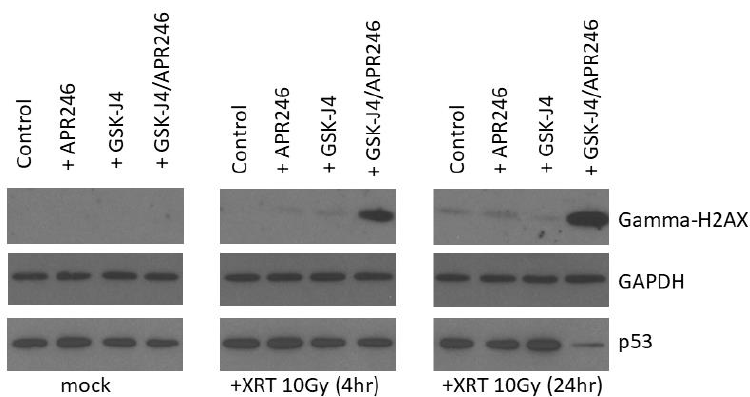
Figure 7. APR-246 combined with GSK-J4 induces DNA repair deficiency in H3.3 K27M DIPG cells following radiation treatment. Western blot analysis of SF8628 H3.3 K27M DIPG cell lysates